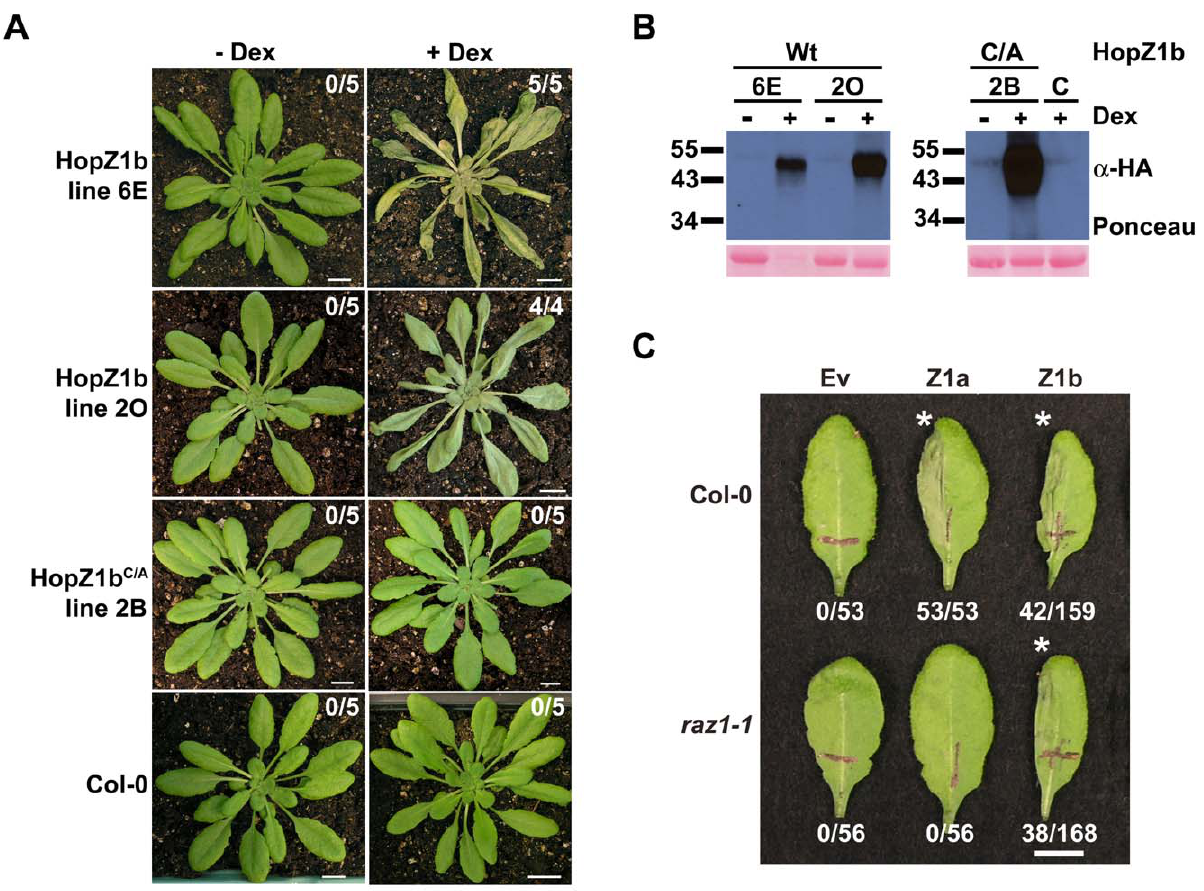
Figure 6. ZAR1 does not recognize HopZ1b. (A) Transgenic homozygous HopZ1b or HopZ1b C/A plants were sprayed with 30 m M dexamethasone or water. C/A indicates the C212A mutation of HopZ1b in the predicted catalytic triad. Photos were taken 24–72 hours post-spraying. The number of plants showing a macroscopic HR is indicated in each box. Scale bar is 1 cm. (B) Immunoblot analysis of HopZ1b or HopZ1b C/A protein expressed in transgenic lines after treatment with 30 m M dexamethasone or water. C/A indicates the C212A mutation of HopZ1b in the predicted catalytic triad. The Ponceau Red stained blot serves as the loading control. The predicted size of HopZ1b-HA is 42.4 kDa. (C) Half-leaves of Arabidopsis Col-0 or zar1-1 plants were infiltrated with 10 mM MgCl 2 or with Pto DC3000 expressing the empty vector (Ev), HopZ1a or HopZ1b with a C-terminal HA tag under its endogenous promoter. The bacteria were syringe infiltrated into the leaves at 5 6 10 7 cfu/mL. Photos were taken 24 hours post- infiltration. The number of leaves showing an HR is indicated below the appropriate construct. HRs are marked with an asterisk. Scale bar is 1